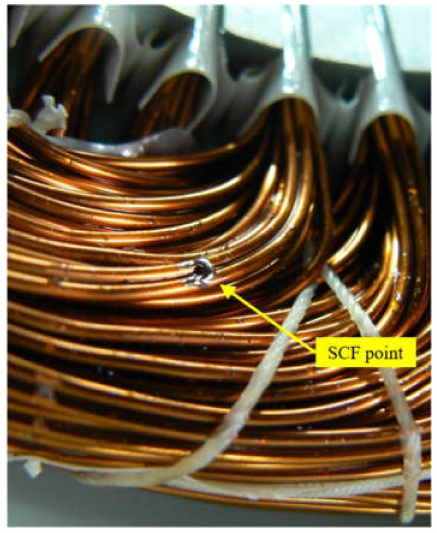
Figure 3. Reproduction of a short-circuit fault